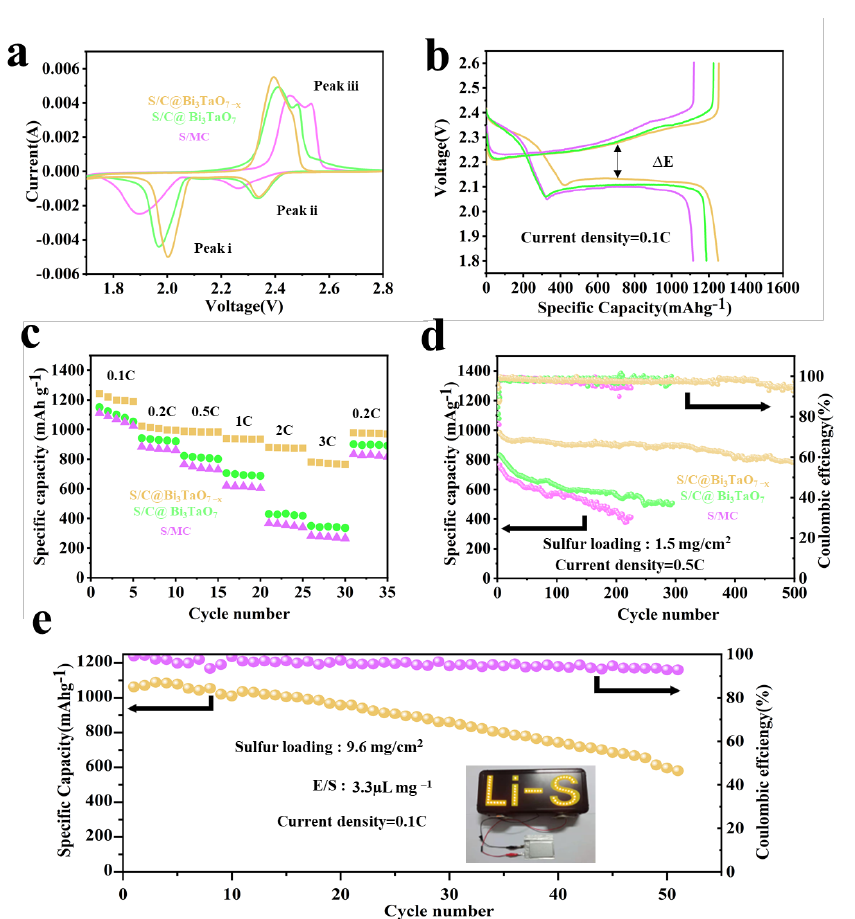
Figure 6. ( a ) CV profiles of coin cells at a scan rate of 0.1 mVs − 1 employing Bi 3 TaO 7 − x, Bi 3 TaO 7 , and MC electrodes. ( b ) Charge–discharge profiles at 0.1 C of various sulfur electrodes. ( c ) Rate performance of different sulfur electrodes. ( d ) Long cycling performances of Bi 3 TaO 7 − x, Bi 3 TaO 7 , and MC electrodes at 0.5 C. ( e ) Cycle performance of the Bi 3 TaO 7 − x -based pouch cell at 0.1 C.